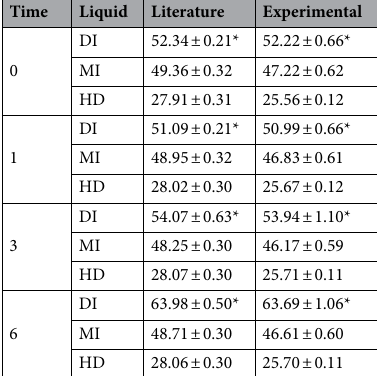
Table 6. SE estimations based on AMF method at different UV/O 3 treatment